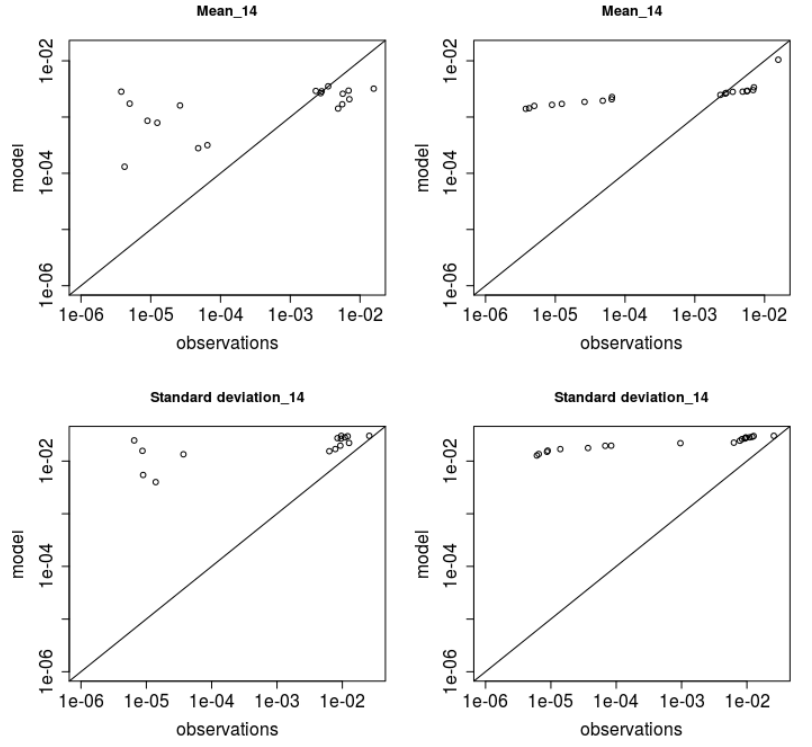
Figure 3. Scatter-plot ( left ) and qq-plot ( right ) for trial 14 (neutral conditions) (g m − 3 )